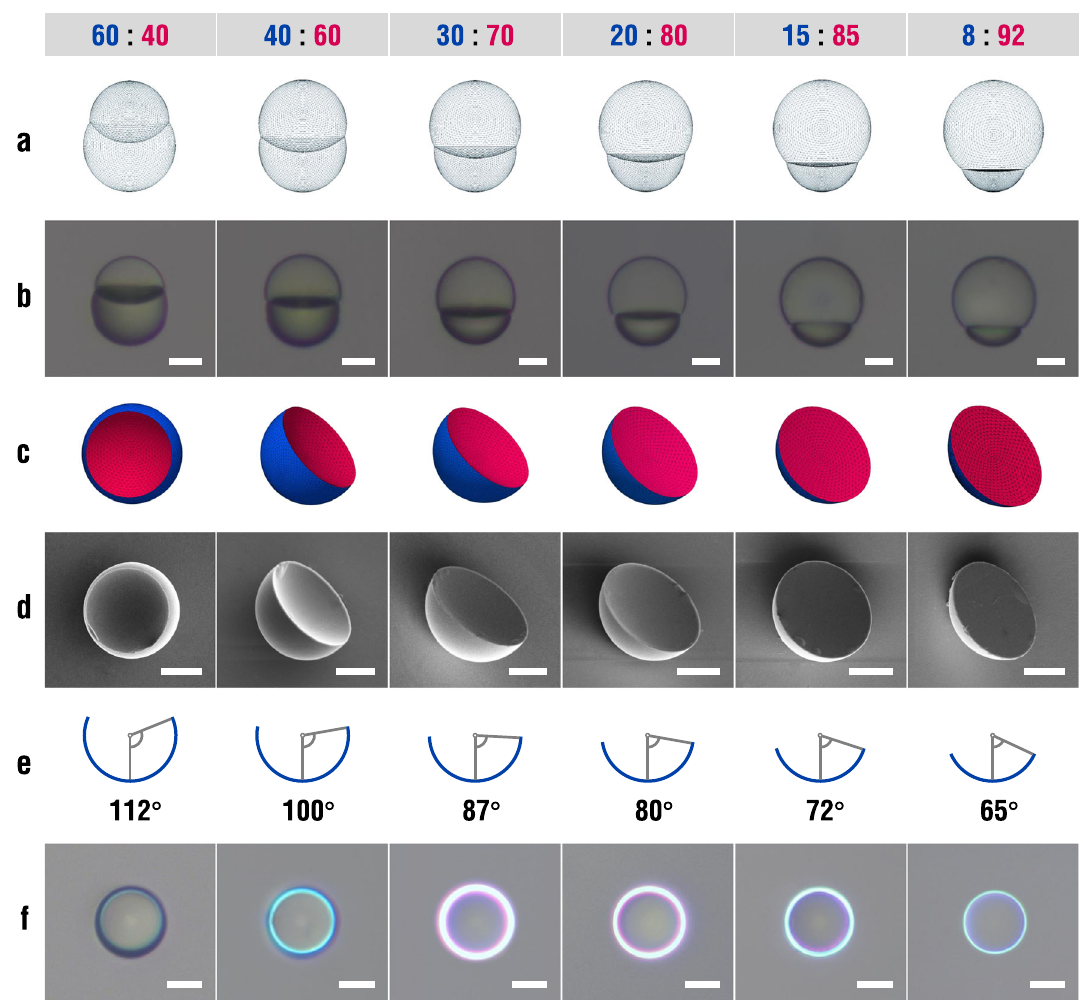
Fig. 4 | Control of micro-crescent geometry. a, b Sets of Surface Evolver model andre fl ectionopticalmicrographofpairedmicroparticleswithvolumeratiosofPS to silicone oil as denoted. Scale bar, 20 μ m. c, d Surface Evolver model and SEM